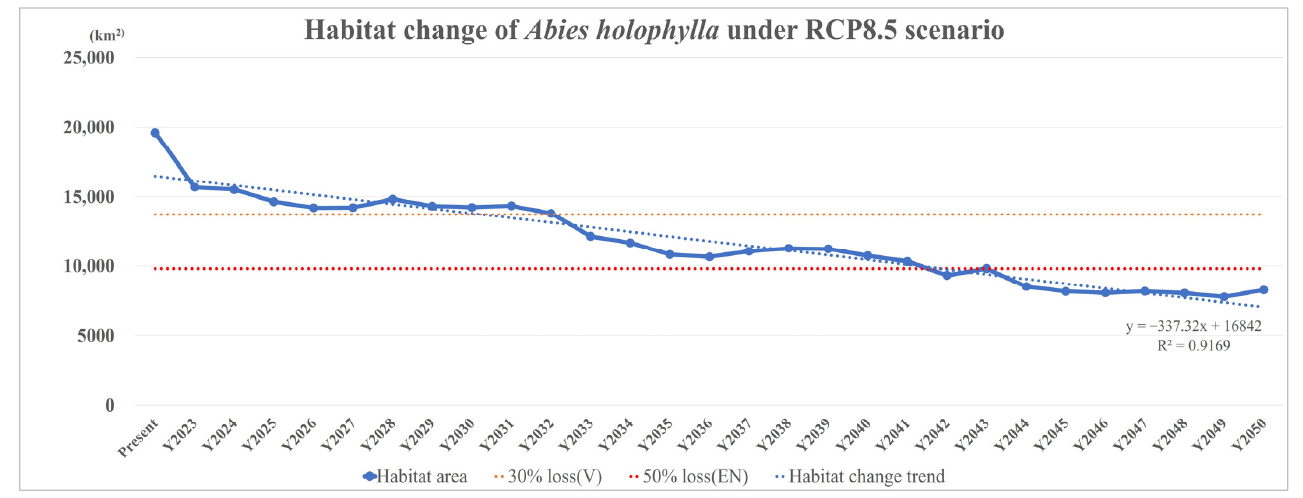
Figure 5. Change in habitat of Abies holophylla under RCP8.5 scenario. The gray dotted line repre- sents habitat change trend and the red dotted line represents 30% loss of habitat from the present habitat area.